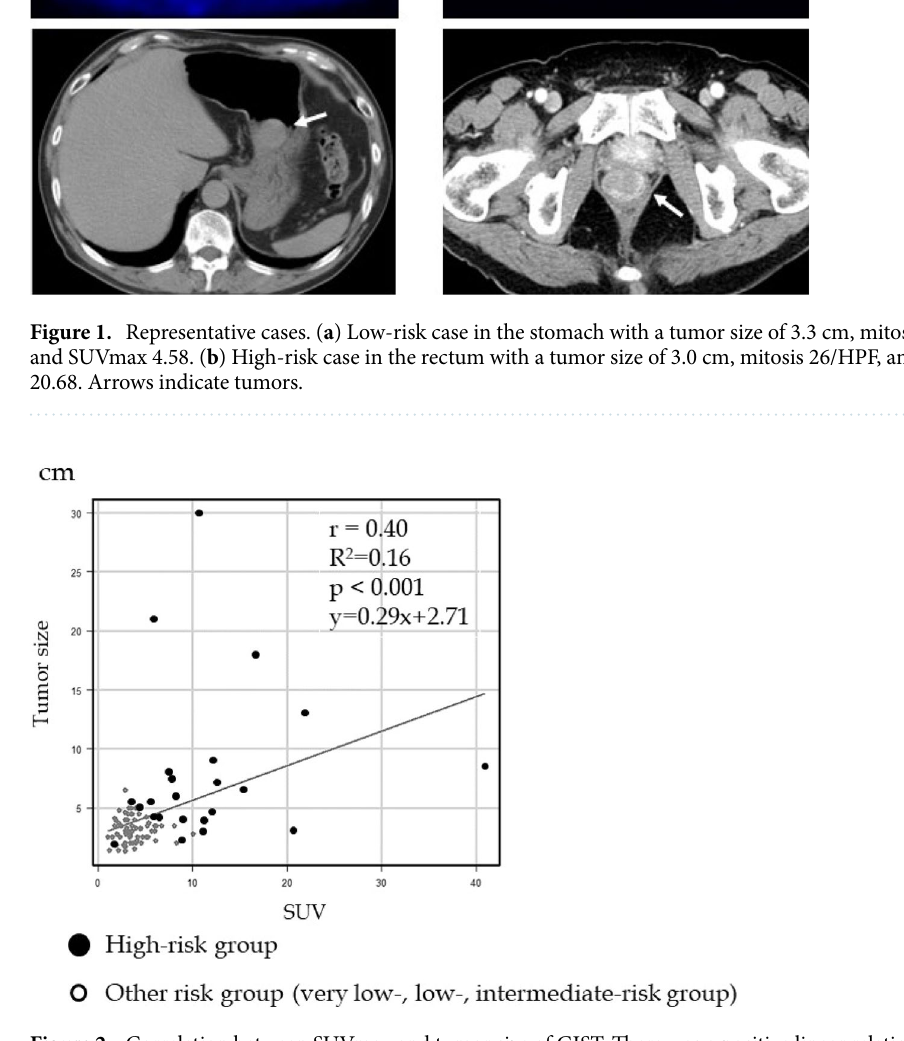
Figure 2. Correlation between SUVmax and tumor size of GIST. There was a positive linear relationship between SUVmax and tumor size. In GISTs with a tumor size of 5 cm or less, 10 patients were in the high-risk group and 8 had SUV ≥